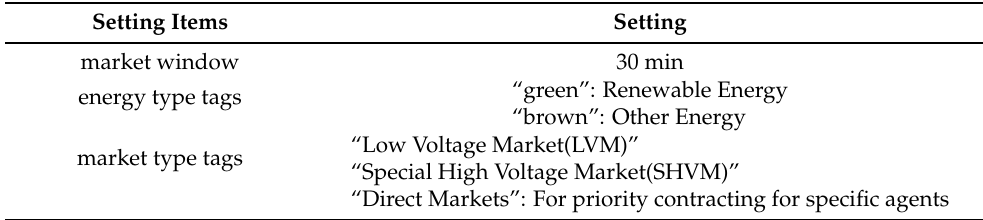
Figure 5. Hardware installed at participant office. Table 7. Demonstration Experiment Market